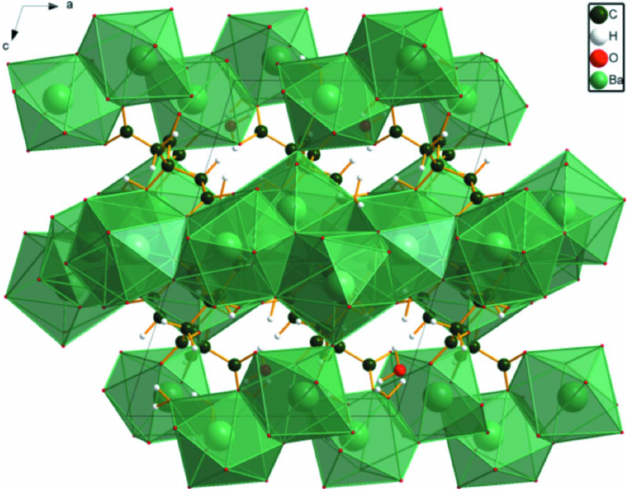
Figure 3 The crystal structure of (I), viewed down the b -axis direction.